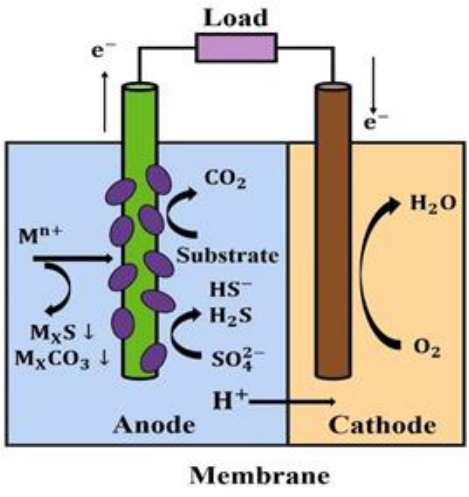
Figure 2. Metal removal on a bioanode.